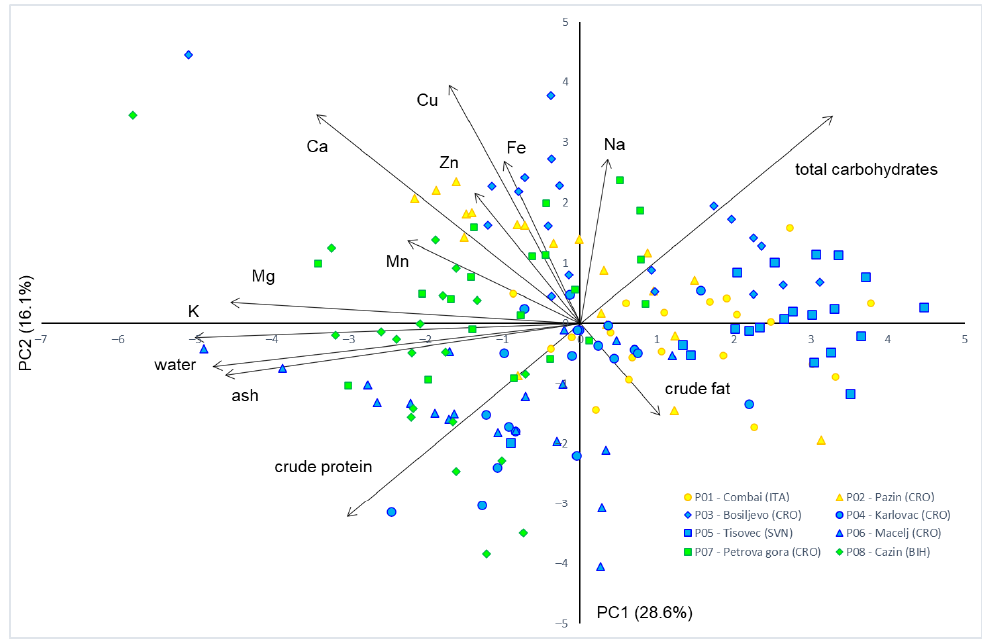
Figure 2. Principal component (PC) analysis of eight sweet chestnut populations based on 13 chemical traits. The color of the signs is related to the biogeographical region and management type: yellow color — sub-Mediterranean high-forest populations; blue color — continental high-forest populations; and green color — continental coppice populations.